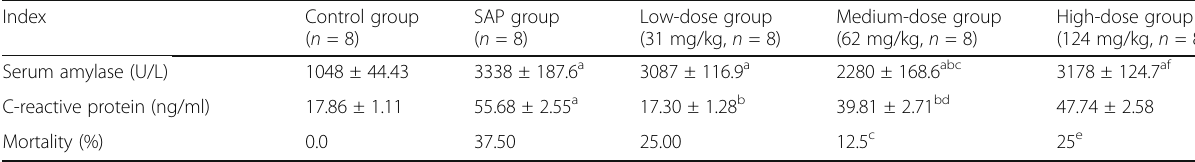
Versus control group, a P < 0.001; Versus SAP group, b P < 0.001; Versus low-dose group, c P < 0.01, d P < 0.001; Versus medium-dose group, e P < 0.05, f P <